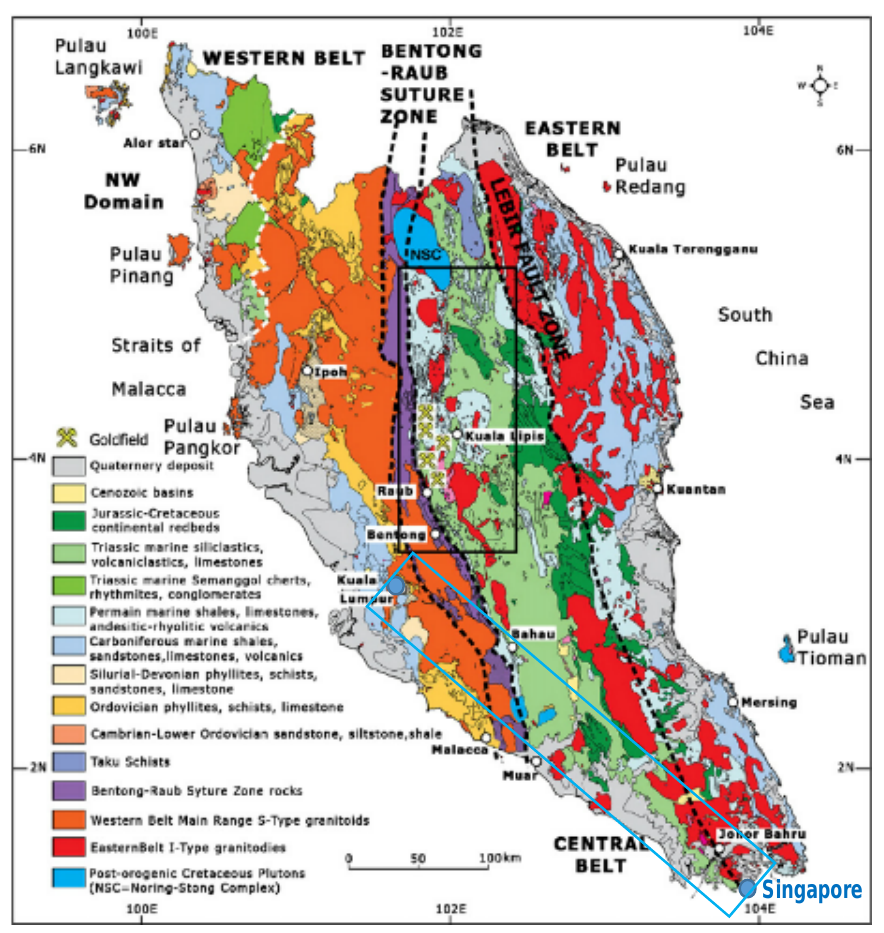
Figure 6. Geology Map of Peninsular Malaysia, modified from [25].